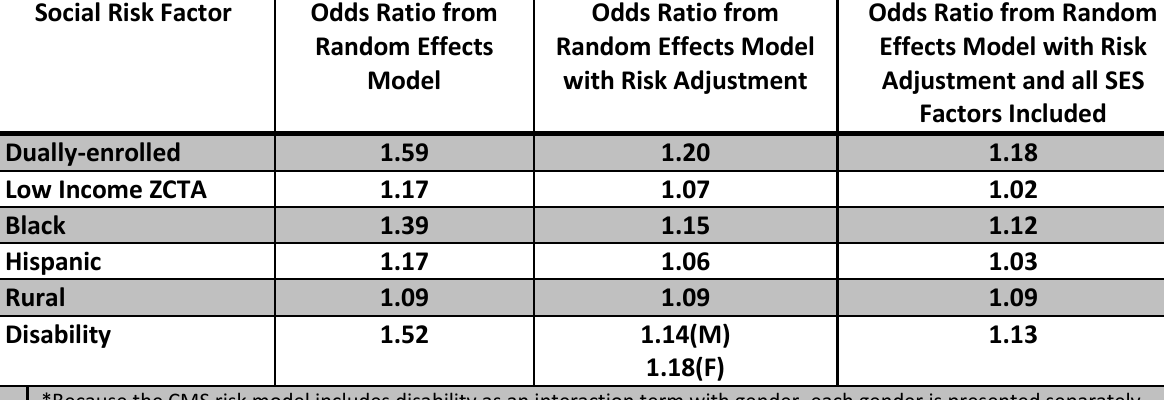
Table 13.6: Social Risk Factors and ED Use, FYs 2012-2014 Social Risk